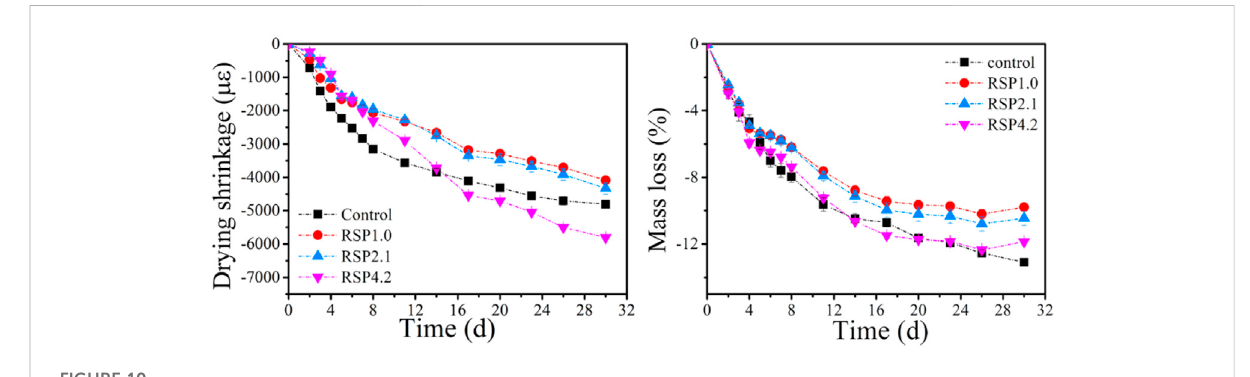
FIGURE 10 Drying shrinkage and mass loss of AAS paste with and without